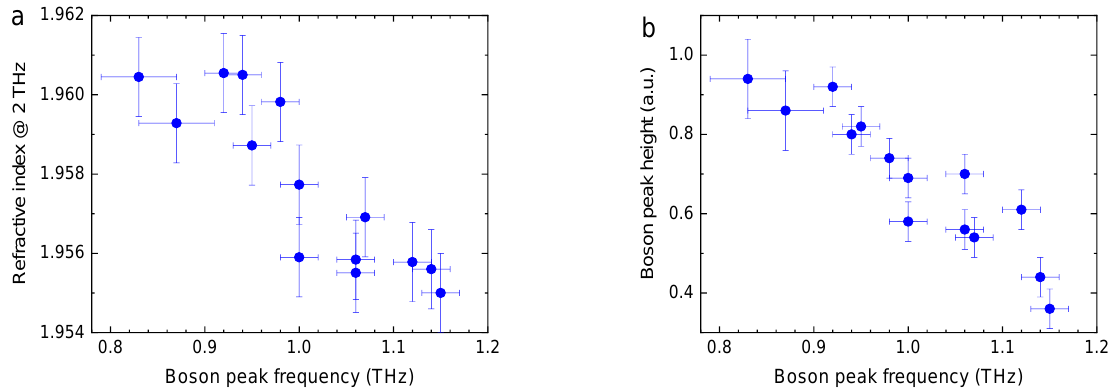
Figure 10. ( a ) Relationship between the refractive index of silica glasses at 2 THz and their Boson peak frequency. ( b ) Relationship between the Boson peak height and its frequency in silica glasses. The peak height is measured as the difference between peak maximum and its base at 3 THz (see Figure 7).